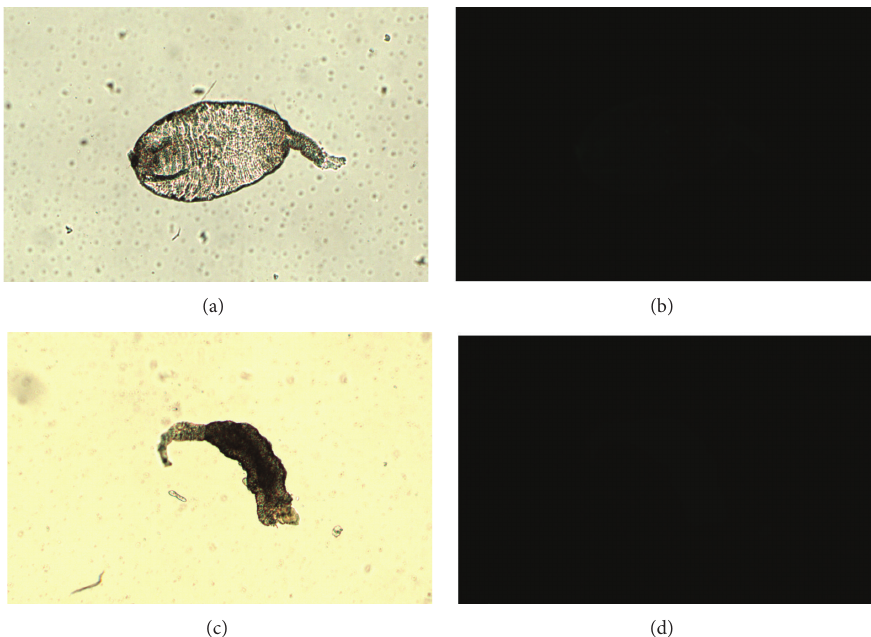
Figure 3: Bright field (a) and fluorescence (b) images of the FITC-CGL. The same images were acquired with the FITC-CGL blocked with D-mannose (c) and (d).